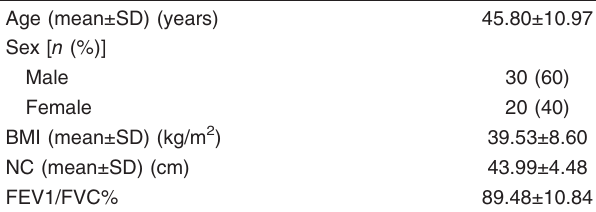
Table 1 Characteristics of all studied participants